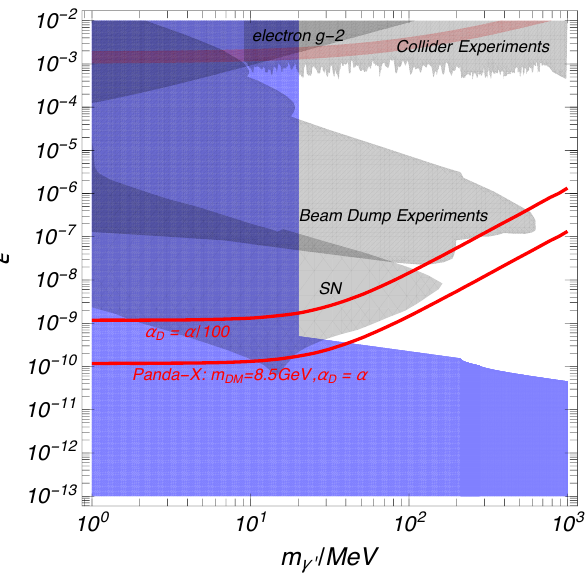
Figure 1 . Constraints on the dark photon parameters. The blue shaded regions are excluded by the cosmological constraints discussed in sections 2.3.1 (left) and 2.3.2 (bottom). We take T QCD 0 = 1 GeV and a F =a QCD 0 = 3, although the result barely depends on their values. The gray shaded regions are excluded by SN 1987A [32, 33], beam dump experiments, and collider experiments [34]. The red lines show the upper limit on (cid:15) at 90% CL for m DM = 8 : 5 GeV